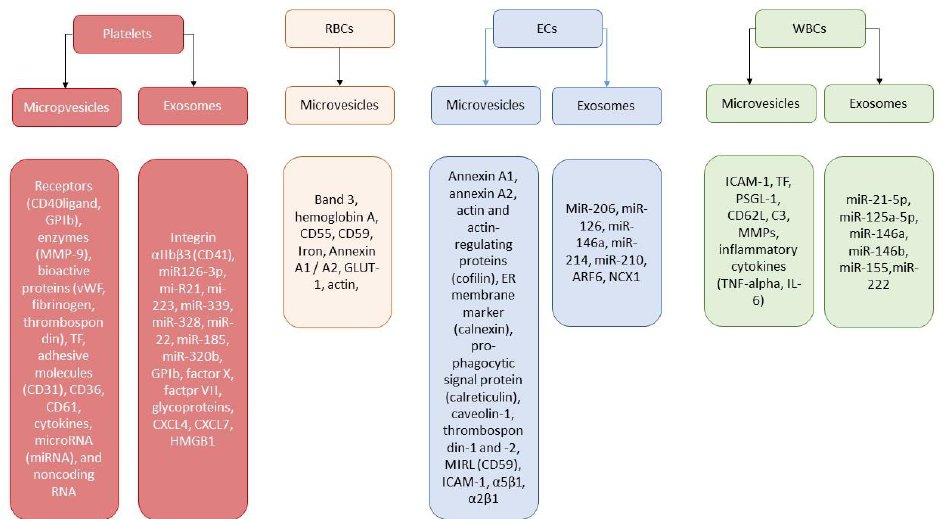
Figure 1. Secretome of EVs originated from different cells. Abbreviations: ARF6, ADP ribosylation factor 6; ECs, endothelial cells; RBCs, red blood cells; ER, endoplasmic reticulum; ICAM-1, intracellular adhesion molecule 1; CD62L, l-selectin; MIRL, membrane inhibitor of reactive lysis; MMPs, metalloproteinases; TNF-alpha, tumor necrosis factor-alpha; TF, tissue factor; vWF; Von Willebrand factor; CXCL, C-X-C motif ligand; HMGB1, high mobility group box 1; PSGL-1, P-selectin glycoprotein ligand-1; WBCs, white blood cells.